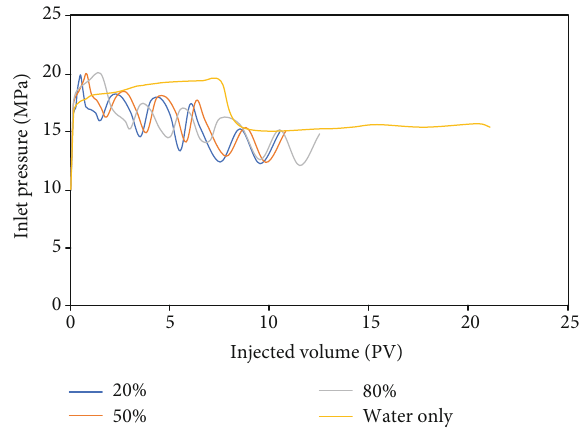
Figure 6: Curve of the relationship between injection volume of alternating gas-water fl ooding and injection pressure in di ff erent times. Figure 9). Compared with continuous water injection and continuous gas injection, oil recovery is improved by 4.89% and 6.88%, respectively.